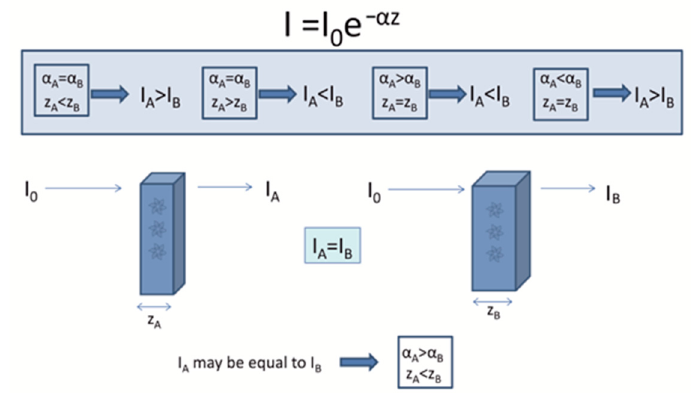
Figure 1. Correlation between absorption coefficient ( α ) and thickness ( z ) and their effect on light transmitted through a sample according to the Lambert Beer’s law. A material with high α (i.e., zirconia) can transmit the same light with a material of lower α (i.e., LDS) if its thickness is accordingly